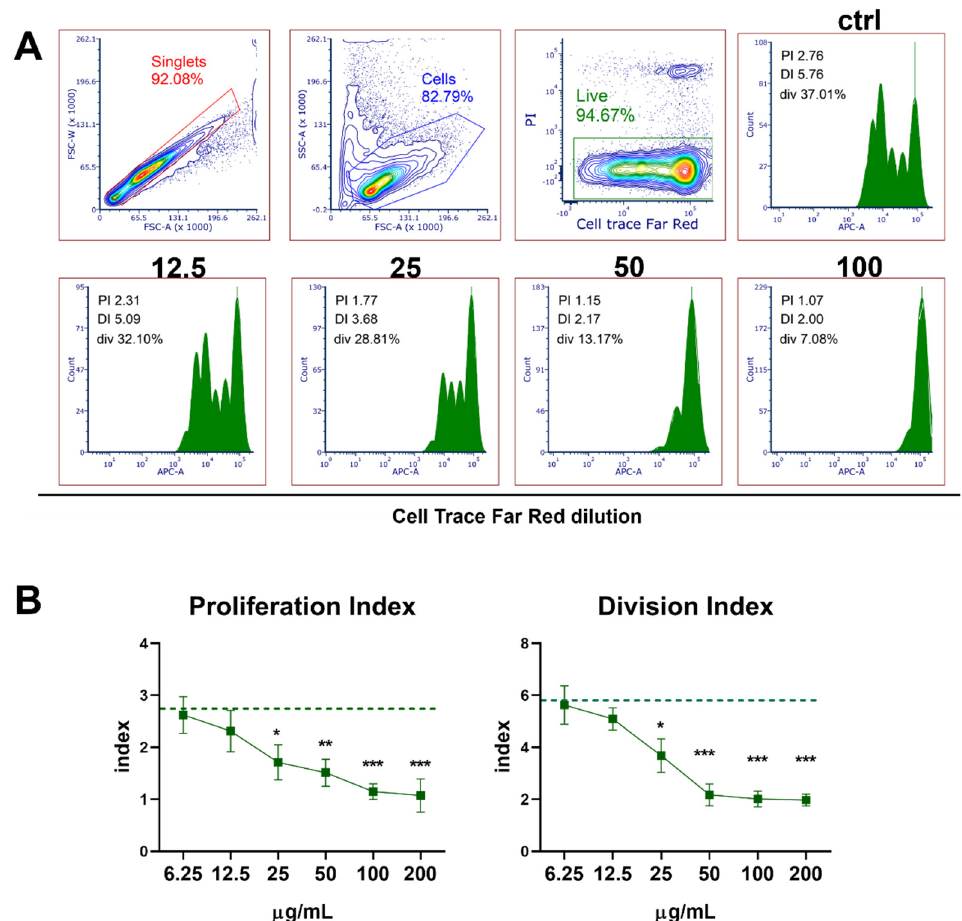
Figure 5. The effects of PoPEx on PHA-stimulated proliferation of PBMC. PBMC (3 × 10 5 /well) pre-labeled with CellTrace Far-Red were cultured with PoPEx (6.25–200 µg/mL) or without PoPEx (ctrl) in the presence of PHA (10 µg/mL) for 4 days, followed by the analysis of Far-Red dilution by flow cytometry. ( A ) A representative gating strategy (the exclusion of doublets, cell debris, and dead (PI+ cells) is shown, and the analysis of Far-Red dilution is shown on histograms (PI-proliferation index, DI-division index, or div-percentage of division) from one experiment, out of 5 with similar results. ( B ) The summarized data for proliferation index and division index is shown as mean ± SD from 5 independent experiments * p < 0.05, ** p < 0.01, *** p < 0.005, compared to control non-treated PHA-PBMC (Friedman test; Dunn’s multiple comparison post-test).